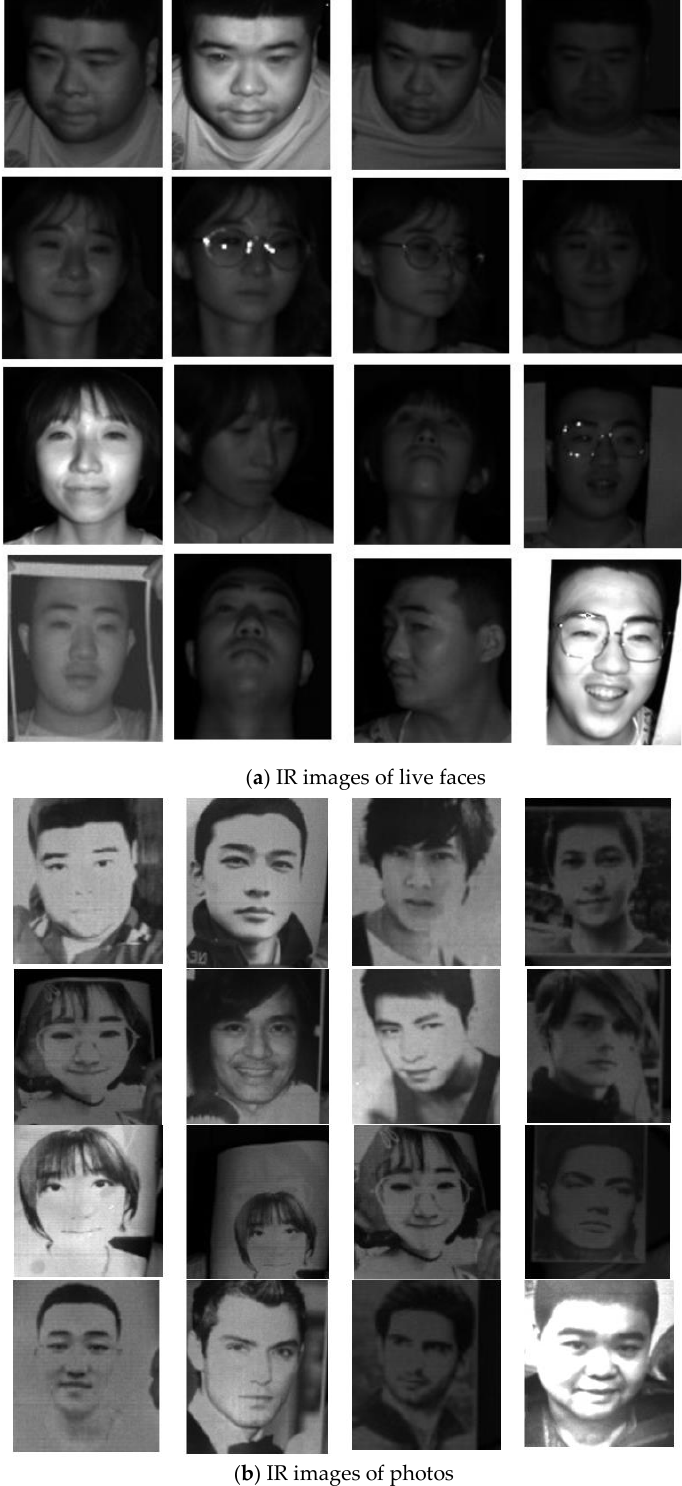
Figure 7. IR pictures collected with a Kinect camera.